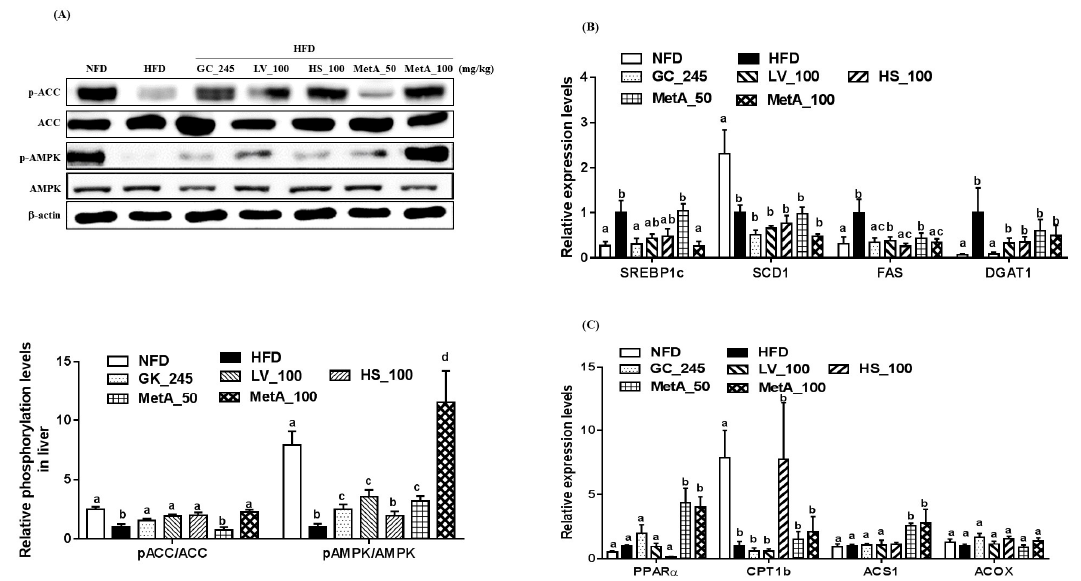
Figure 8. Effects of LV, HS, and MetA on ACC and AMP-activated kinase (AMPK) phosphorylation in liver tissue of obese mice fed HFD. Quantification of proteins in immunoblot ( A ). A representative blot is shown (A, upper), Densitometric analyses of p-ACC and ACC, and p-AMPK and AMPK (A, lower) in liver. Relative signal strength of AMPK, p-AMPK, ACC, p-ACC, and internal control ( β -actin) was quantified for each band and the relative expression levels of quantification of proteins were calculated as a ratio to HFD-HFD gene expression. mRNA expression levels of lipogenesis ( B ) and fatty acid oxidation ( C )-related genes were analyzed using qPCR. HFD, 60% high-fat-diet control group; HFD + GC_245, HFD contains Garcinia cambogia extract (245 mg/kg)-fed group; HFD + LV_100, HFD contains lemon verbena extract (100 mg/kg)-fed group; HFD + HS_100, HFD contains Hibiscus flower extract (100 mg/kg)-fed group; HFD + MetA_50, HFD contains the MetA-mixed extract of lemon verbena plus Hibiscus flower (50 mg/kg)-fed group; HFD + MetA_100, HFD contains the MetA-mixed extract of lemon verbena plus Hibiscus flower (100 mg/kg)-fed group. Values are expressed as means ± SEM ( n = 10). a–d Values within arrow with different letters are significantly different from each other at p < 0.05 as determined using Turkey’s multiple-range test.